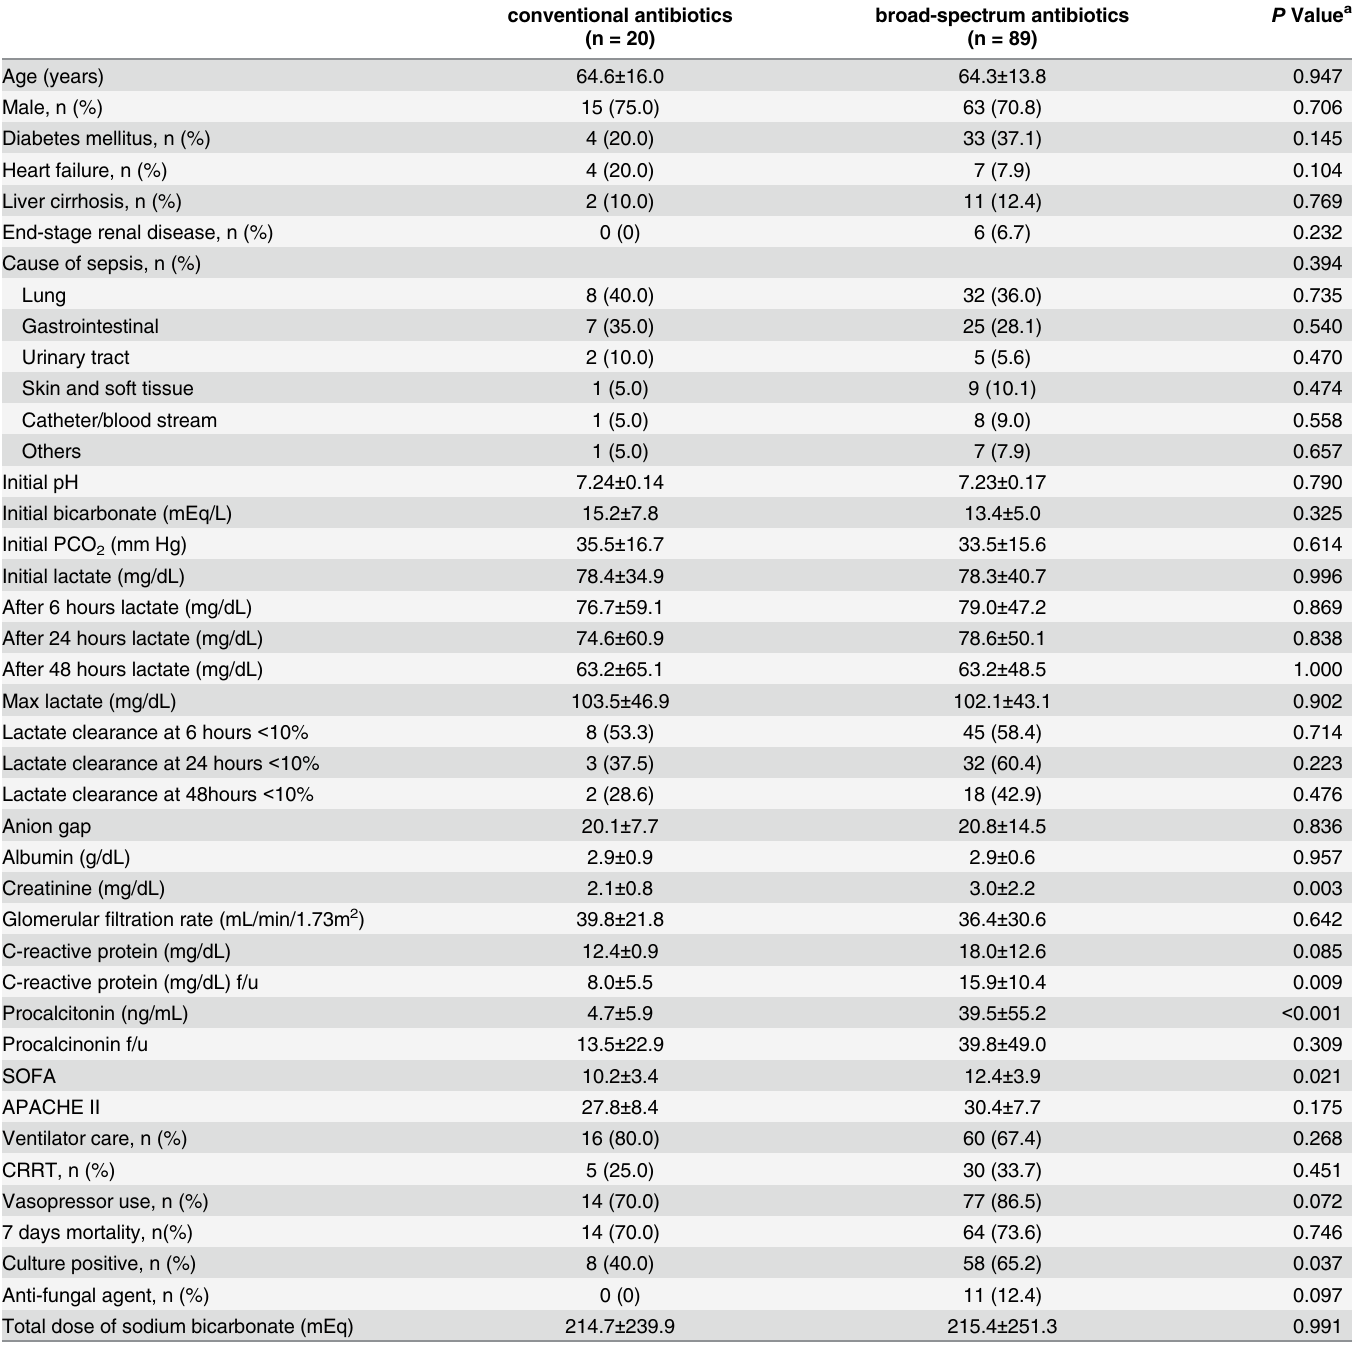
Table 3. Patient characteristics according to